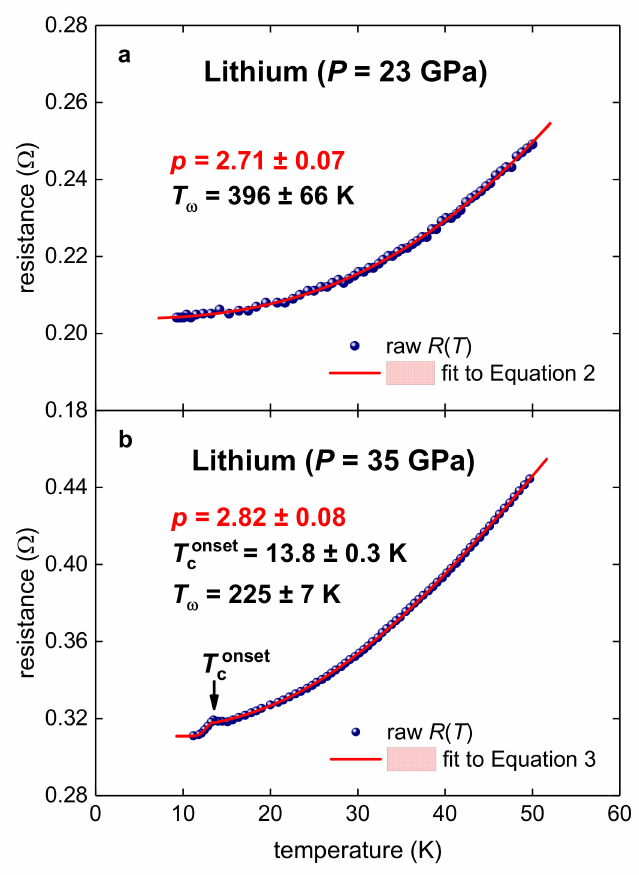
Figure 1. Resistance data, R ( T ), and fits to ( a ) Equation (2) and ( b ) Equation (3) for highly com- pressed lithium (raw R ( T ) data reported by Shimizu et al. [20]). ( a )—deduced p = 2.71 ± 0.07 and T ω = 396 ± 66 K; the fit quality is 0.9990. ( b )—deduced p = 2.82 ± 0.08, T onset c = 13.8 ± 0.3 K, T ω = 225 ± 7 K; the fit quality is 0.9998. Confidence bands at 95% are shown by pink shaded